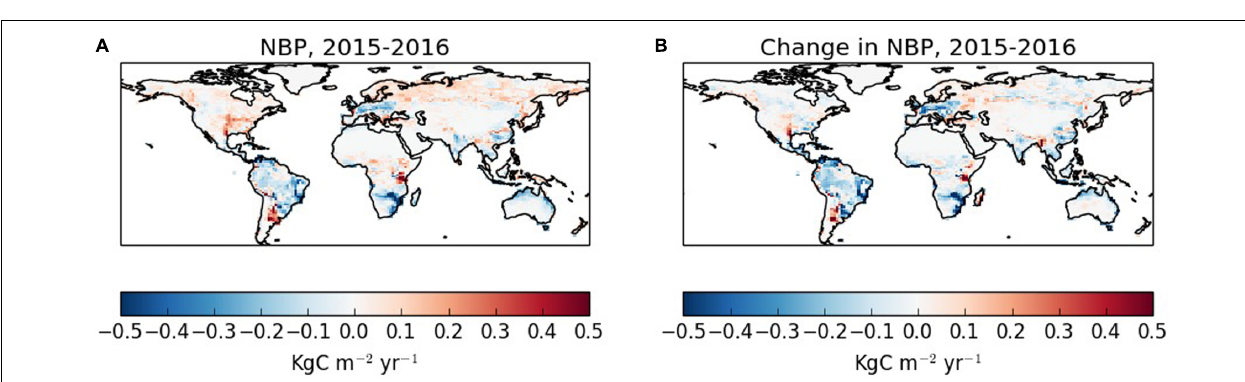
FIGURE 9 | Global Net Biome Productivity (NBP) July 2015–June 2016 (A) , and change in NBP due to El Niño (B) simulated by